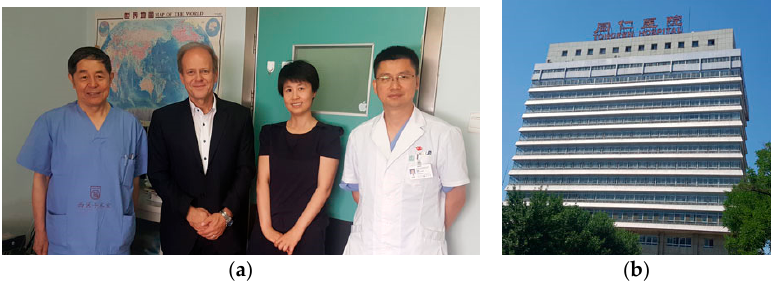
Figure 9. ( a ) Professor Zhang Bingxi (left), Professor Pan Chuxiong (Head of the Department of Anesthesiology), Dr. Sun Yanxia (middle), and Professor Gerhard Litscher. ( b ) Tongren Hospital